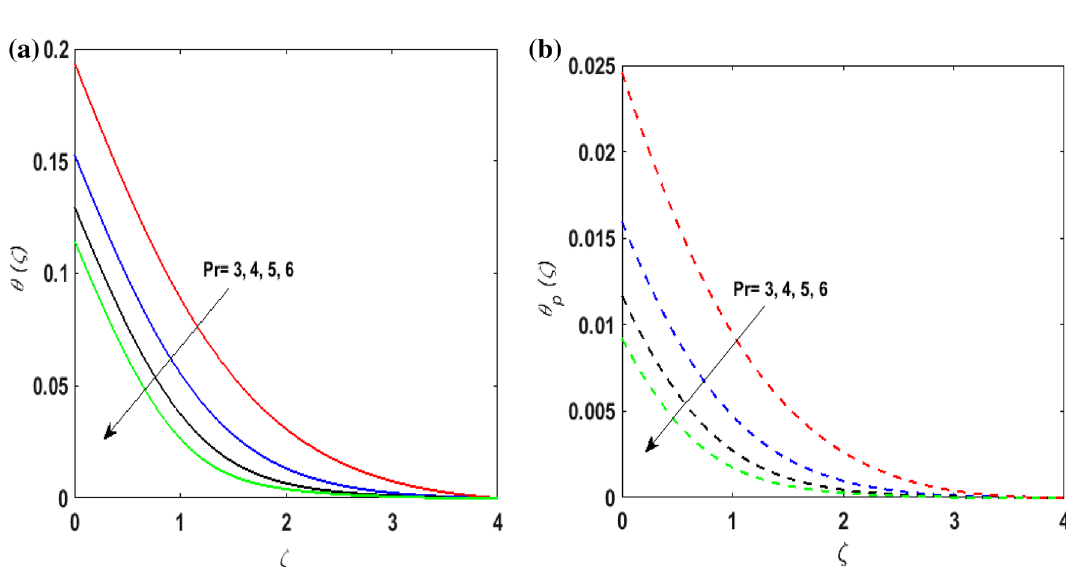
Figure 7. ( a ) θ(ζ) for various Pr . ( b ) θ p (ζ) for various Pr